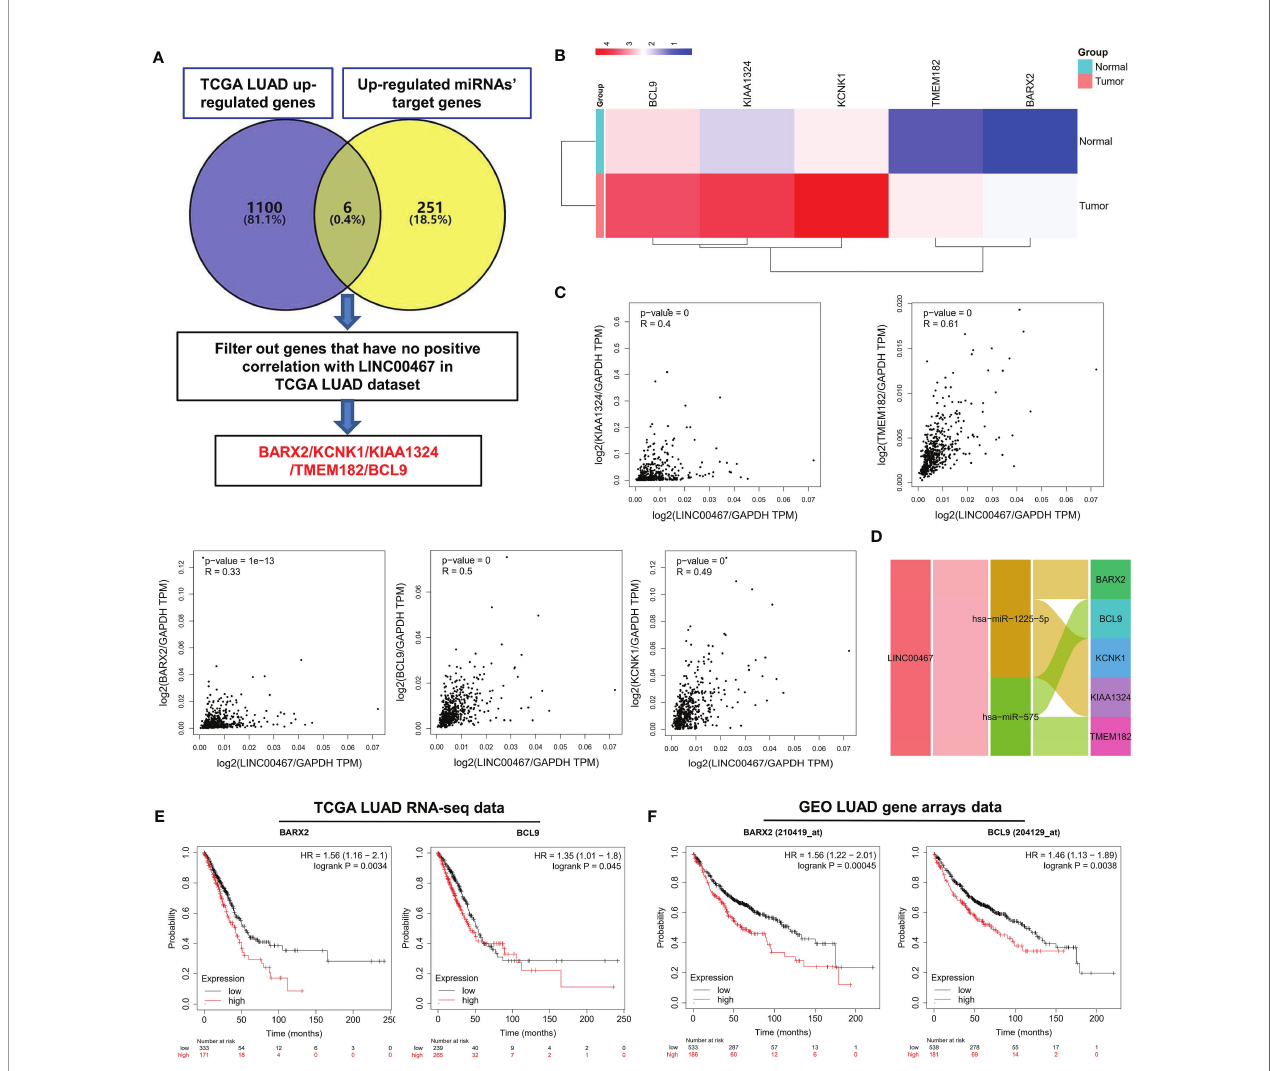
FIGURE 7 | Screening of LUAD prognostic biomarkers in the LINC00467-mediated ceRNA network. (A) Flowchart for the identi fi cation and analysis of candidate genes. (B) Multiple gene comparison analysis was performed using GEPIA2, which revealed the expression of the candidate genes in LUAD tumor versus normal tissues. The density of color in each block represents the median expression value. T indicates tumour and N indicates normal. Use log2(TPM+1) transformed expression data for plotting; (C) Correlation analysis was performed via GEPIA2, which indicated the relationships between the expression levels of the candidate genes and LINC00467 in LUAD. (D) Sankey diagram for the LINC00467 ceRNA network. Each rectangle represents a gene, and the connection degree of each gene is visualized based on the size of the rectangle. Kaplan-Meier curve of the TCGA RNA-seq (E) and Gene Expression Omnibus LUAD gene arrays (F) data, revealing that BARX2 and BCL9 expression correlate with overall survival. The horizontal axis indicates the overall survival time in months, and the vertical axis indicates the survival